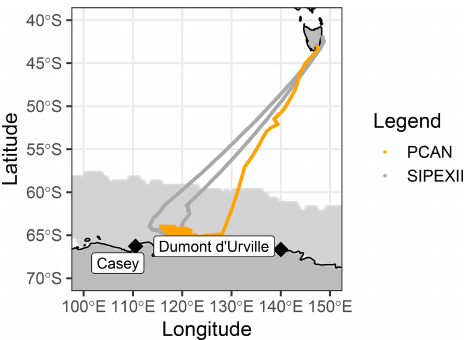
Figure 1. Voyage tracks of the SIPEX-II (spring 2012, grey) and periods of the PCAN voyage (summer 2017, orange), for which measurements were analysed. Measurements from the southward PCAN transit are excluded due to instrument malfunction. Grey shading represents the sea ice area observed at the midpoint of the SIPEXII voyage, as detected by the Nimbus-7 satellite (Na- tional Snow and Ice Data Centre, 2021). No sea ice was present in the plotted region at the midpoint of the PCAN voyage. Nearby Antarctic stations are plotted to assist interpretation. An interactive map of RV Investigator voyage tracks can be found here: https: //www.cmar.csiro.au/data/underway/?survey=in2017_v01 (last ac- cess: 2 June